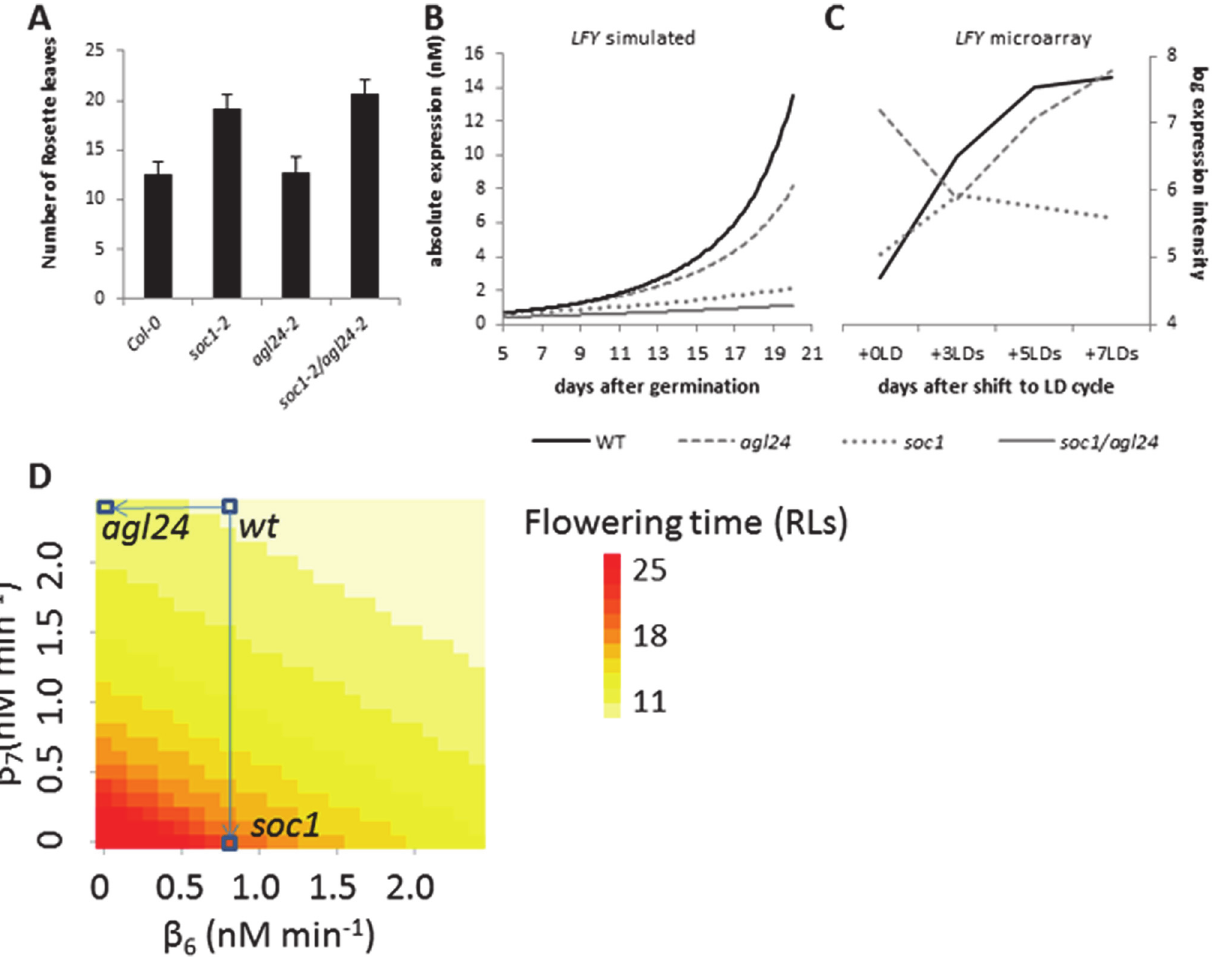
Fig 4. Effect of knockout mutations (agl24, soc1 and soc1/agl24) on LFY expression and on flowering time. (A) Number of rosette leaves counted at the onset of flowering for wild type and mutants. The plants were grown in long-day conditions at 23°C. (B-C) LFY expression in wild type and mutants from simulations (B) or microarray experiments (C). The simulations show the expression time-course over 20 days after germination; the microarray data consist of four time-points after transfer of plants grown in short-day to long-day conditions. (D) Effect of efficiency by which LFY expression is activated by AGL24 ( β 6 ) and SOC1 ( β 7 ), on predicted flowering time. Flowering time, predicted flowering time for given values of parameters. Blue boxes in heatmap indicate best-fit model parameters and the two mutants soc1 and agl24 ; arrows point from wild type model to mutants.